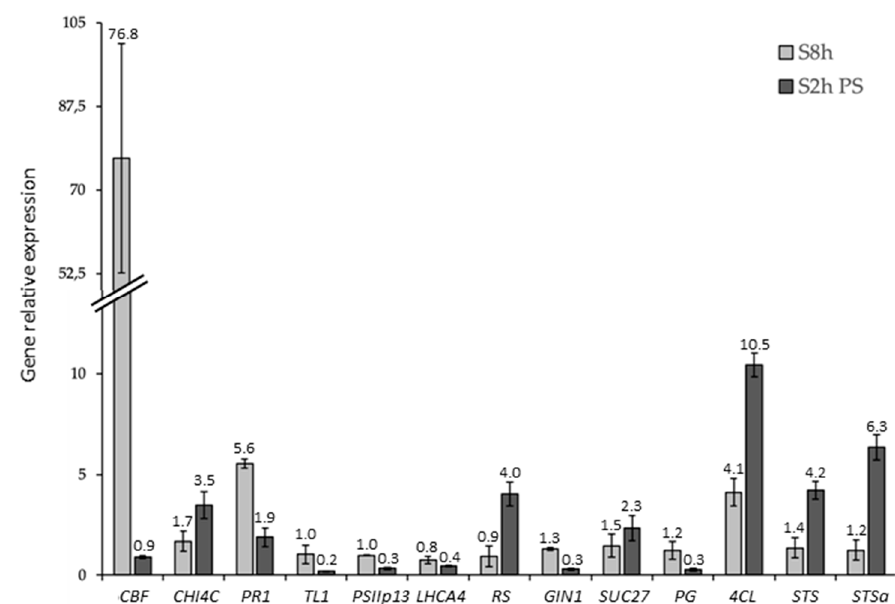
Figure 2. Microarray analysis validation by RT-qPCR. The expression levels of 15 selected genes were quantified by RT-qPCR at 8 h and 2 h PS. The y axis indicates the fold change in gene expression relative to the control plant at T8 h and T2 h PS. The expression profiles were similar by RT-qPCR and microarrays analysis. The data were obtained from three independent biological replicates and two technical repetitions. The numbers above the bars indicate the average fold change values with respect to the control conditions.